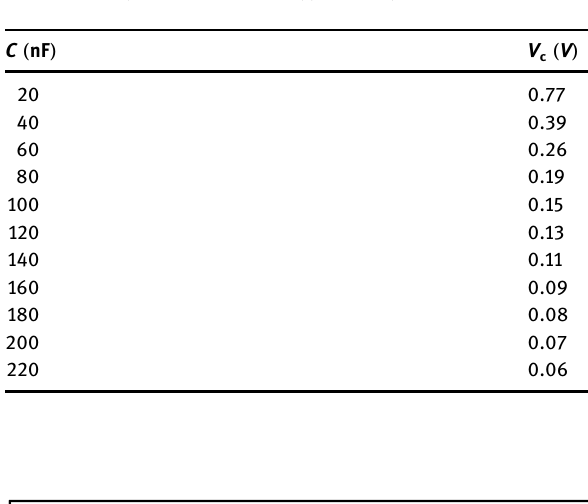
Table 4: Cavity voltage for three types of capacitors